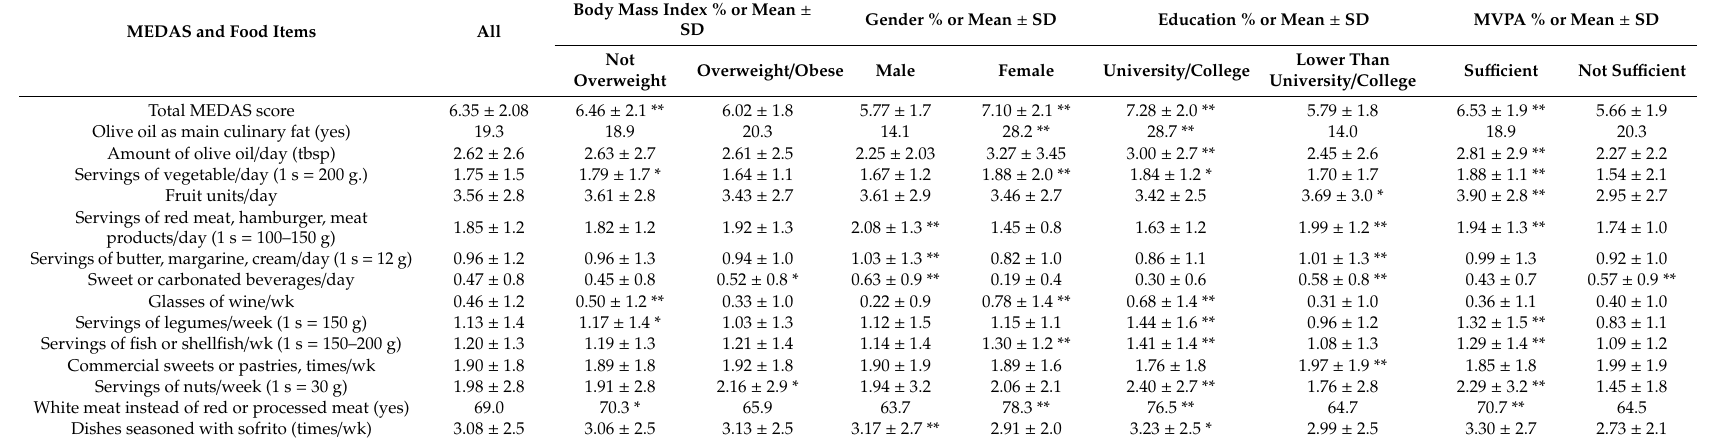
Table 3. Comparison of means and percentage distributions of eating habits among Lithuanian young adults aged 18–36 years old. MEDAS and Food